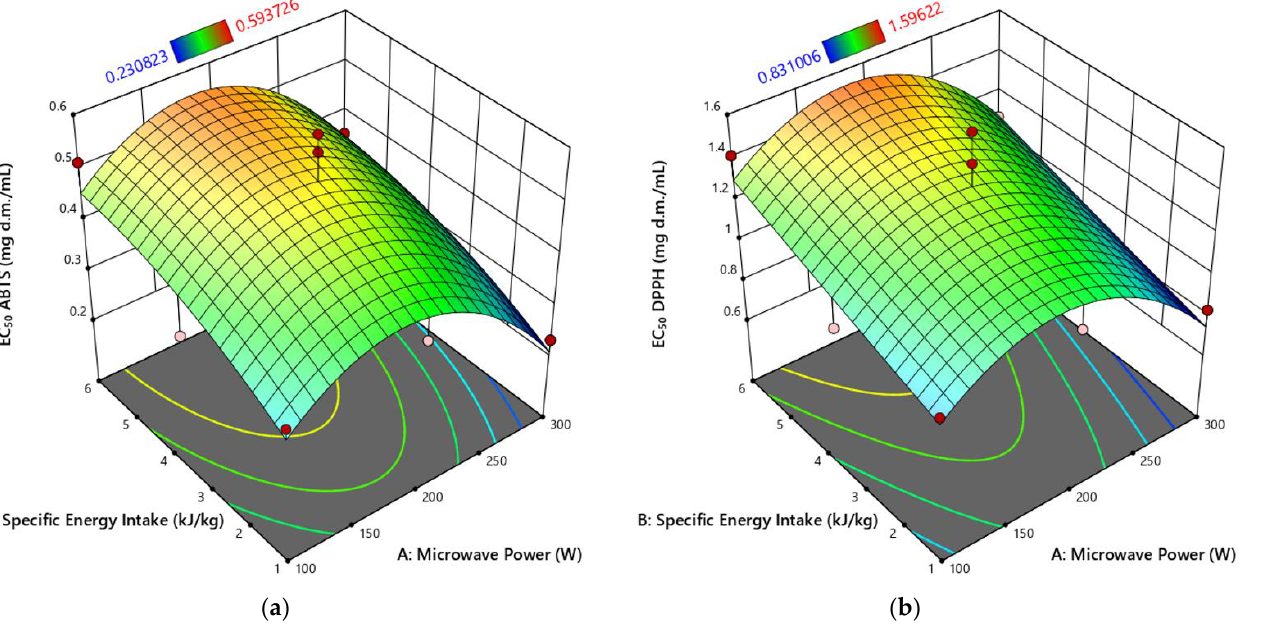
Figure 6. Response surfaces of ability to scavenge: ( a ) ABTS • + radical cations ( EC 50 ABTS); ( b ) DPPH • radicals ( EC 50 DPPH) by apples treated with PEF prior to microwave-convective drying, depending on the microwave power (factor A) and specific energy intake (factor